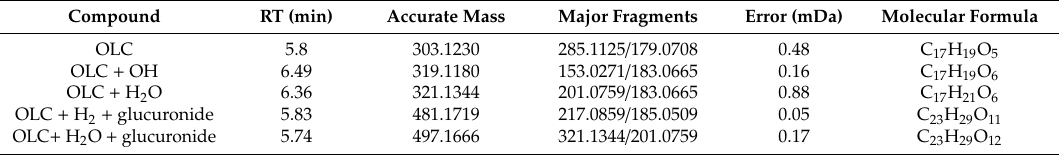
Table 1. Oleocanthal (OLC) and its metabolites identified in lumen and plasma samples using an